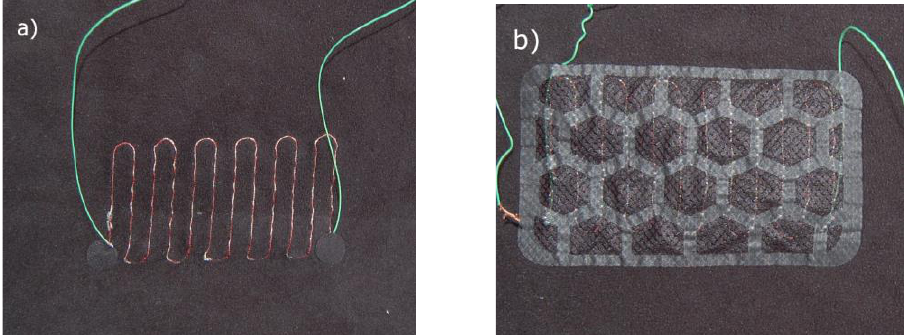
Figure 10. Photographs of heating inserts after 25 cycles of washing — inner surface of variant A ( a ) and inner surface of variant B ( b ).